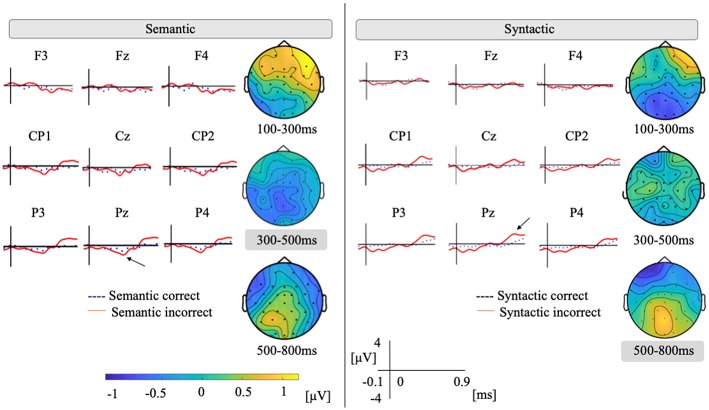
Grand average of nine representative electrodes of semantic and syntactic conditions. Vertical axis ranges between −4 and +4. Positivity is plotted up. We plotted −100 to 900 ms to the stimuli onset. Topographical map shows a difference wave between incorrect and correct conditions.